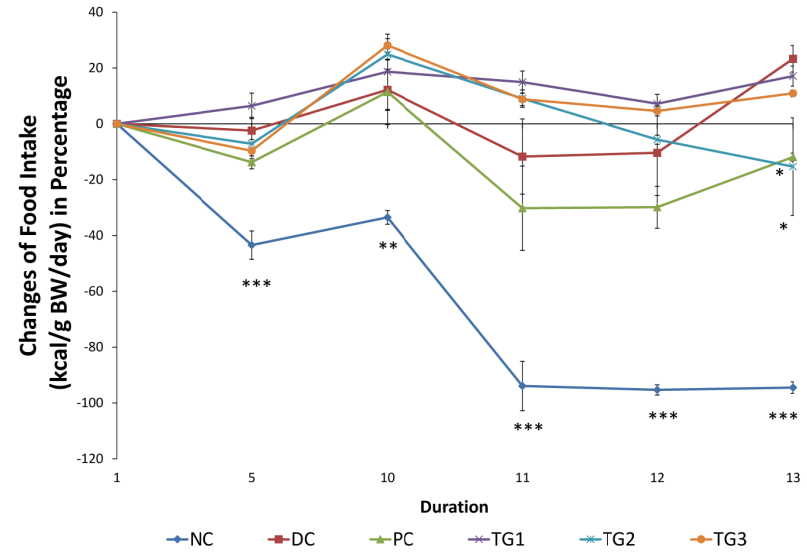
Figure 5. Percentage of change in food intake (kcal/g b.w./day) during sub-chronic treatment with Gongronema latifolium extract. Values are expressed as the mean ± SEM, * = p < 0.05; ** = p < 0.01; *** = p < 0.001 vs. DC.